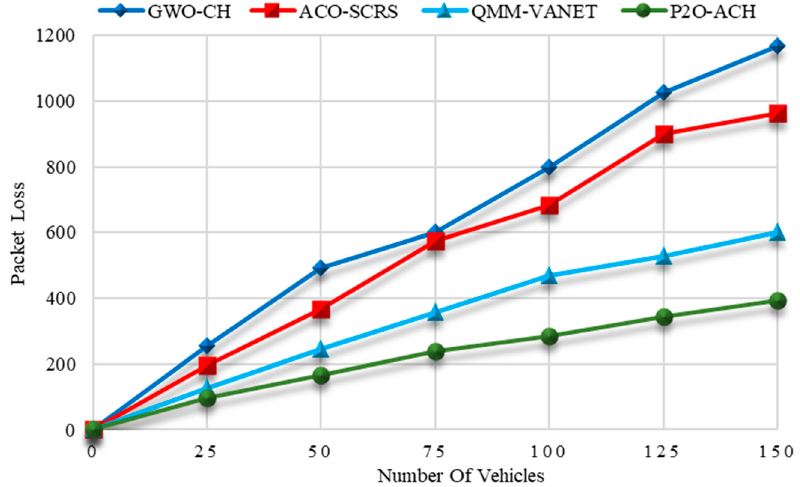
Figure 4. Packet Loss Calculation.